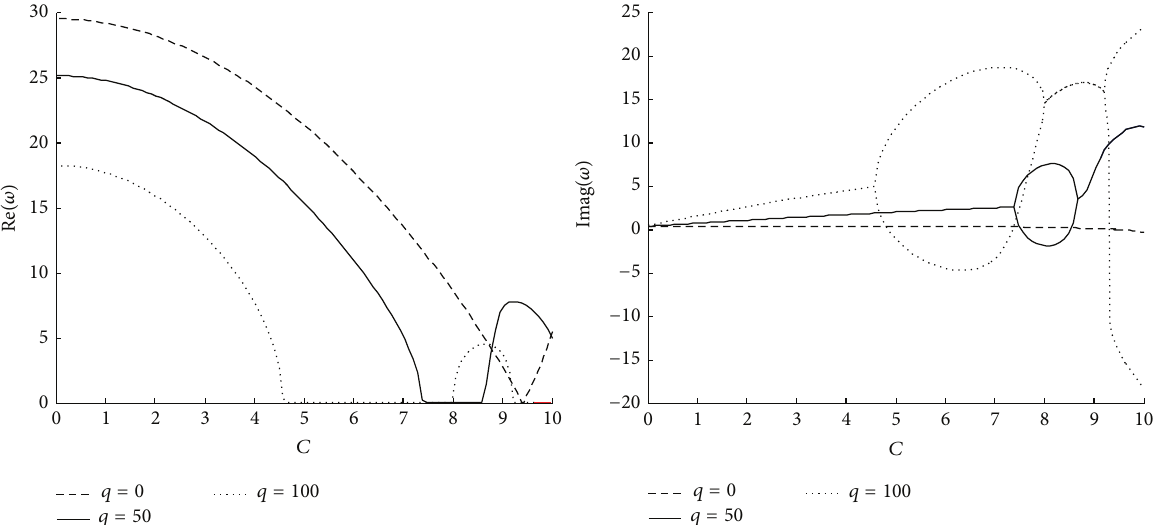
Figure 8: Dimensionless complex frequencies versus dimensionless axially moving speed 𝐶 ( 𝐻 = 10 −3 , 𝑟 = 1 , 𝑈 = 20 , and 𝜆 = 0.05)